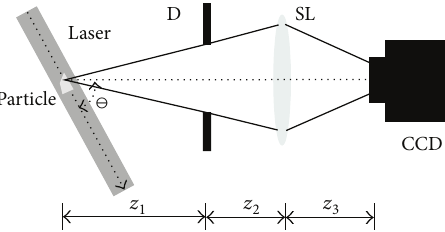
Figure 2: Experimental setup (schematic representation; the setup is not to